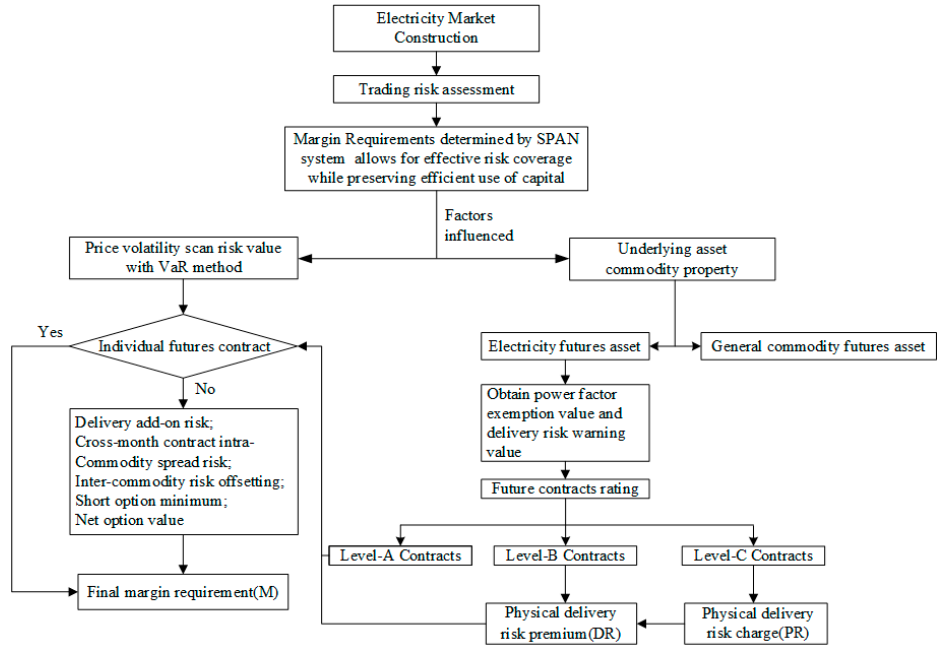
Figure 2. An overview of SPAN-based margin calculation.